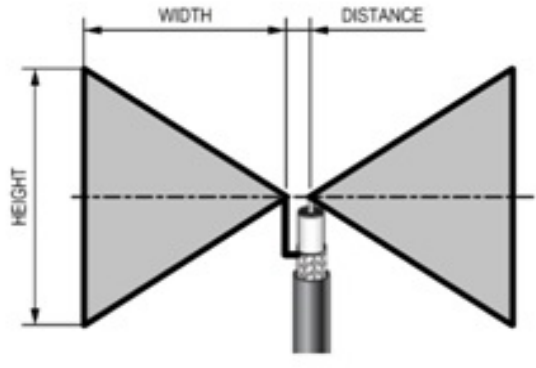
Figure 8. Bowtie antenna [60].